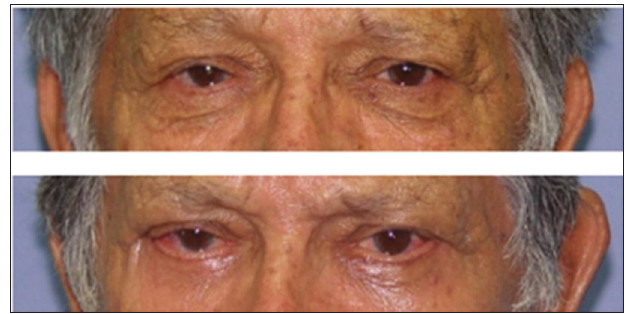
Figure 1. Patient with bilateral chemosis after blepharoplasty with